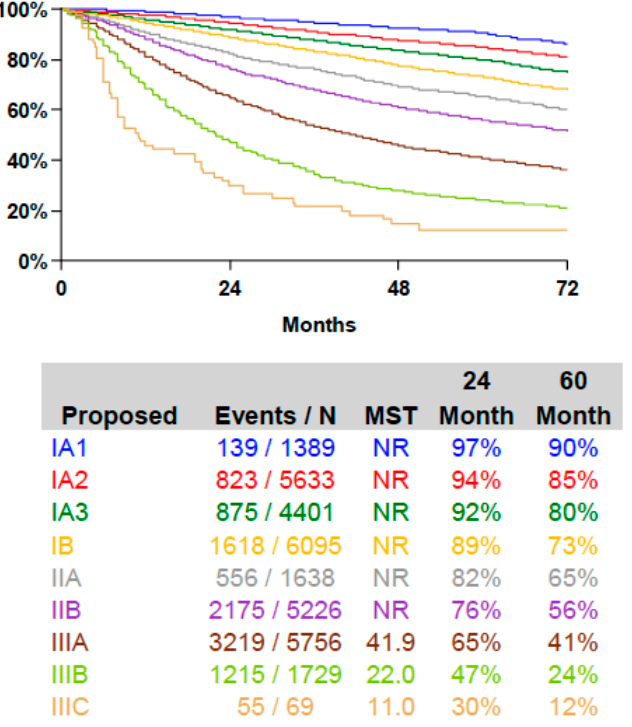
Figure 1. Survival after surgical resection of lung cancer according to TNM8 stage grouping [2].